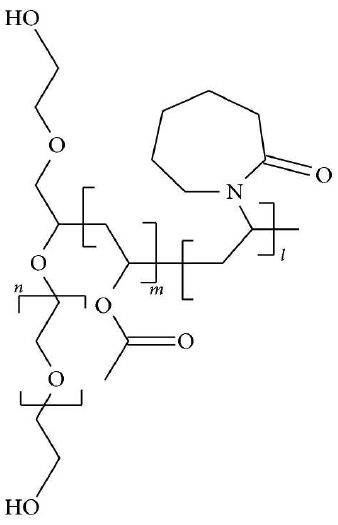
Figure 2. Chemical structure of Soluplus ® .